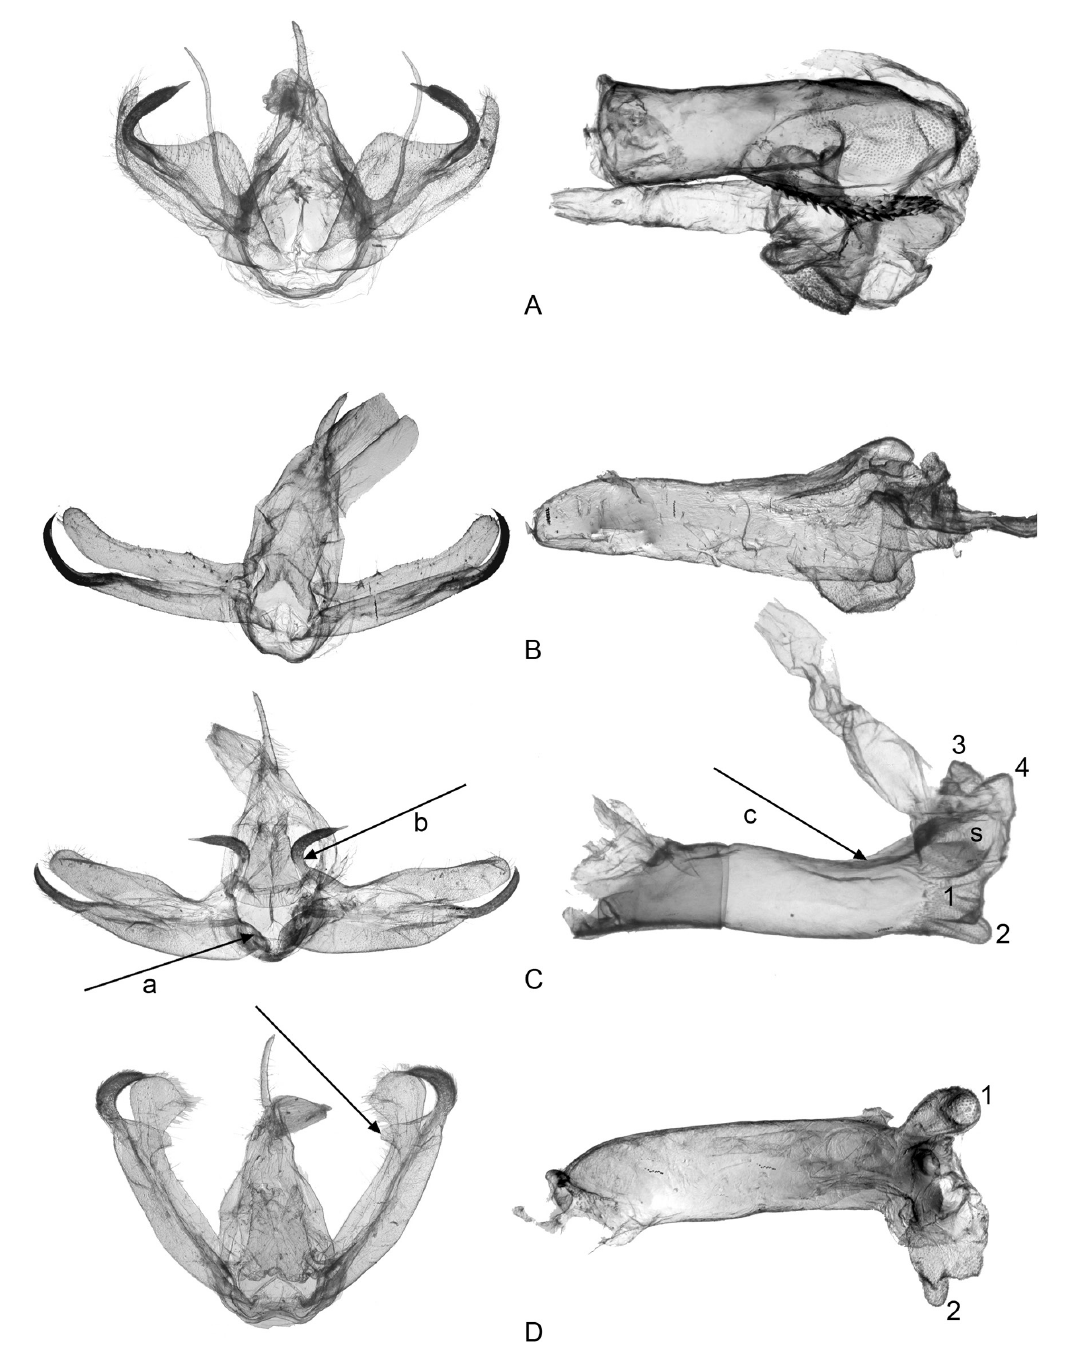
Fig. 4. Male genitalia. Figures are not in equal proportion; the aedeagus, on the right, is enlarged. A . Nanna ceratopygia Birket-Smith, 1965, ♂, Gabon, Makokou-Ipassa, 500 m, 0°30’43’’N 12°48’13’’E, 19 Feb.-11 Mar. 2011, gen. prep. nov. 729/13 MAD. B . Nanna eningae (Plötz, 1880), ♂, Gabon, Makokou-Ipassa, 500 m, 0°30’43’’N 12°48’13’’E, 19 Feb.-11 Mar. 2011, gen. prep. n. 697/12 MAD. C . Nanna semigrisea sp. nov., ♂ paratype, Gabon, Makokou-Ipassa, 500 m, 0°30’43’’N 12°48’13’’E, 19 Feb.-11 Mar. 2011., gen. prep. n. 698/12 MAD. Arrows: a = ventral sclerotization of the basis valvae; b = processus basalis plicae; c = distal sclerotized bar. s = tha moderate swelling in the vesica. 1-4 = lobes of the vesica. D . Nanna molouba sp. nov., ♂ paratype, Gabon, Makokou-Ipassa, 500 m, 0°30’43’’N 12°48’13’’E, 5-10 Apr. 2010, gen. prep. n. 562/10